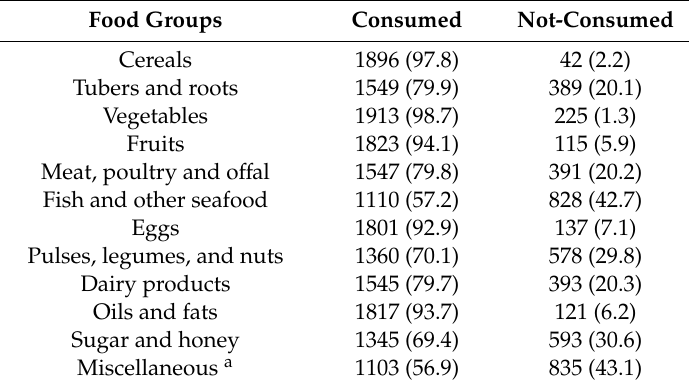
Table 1. Food groups consumption in the last 24 h ( n ,